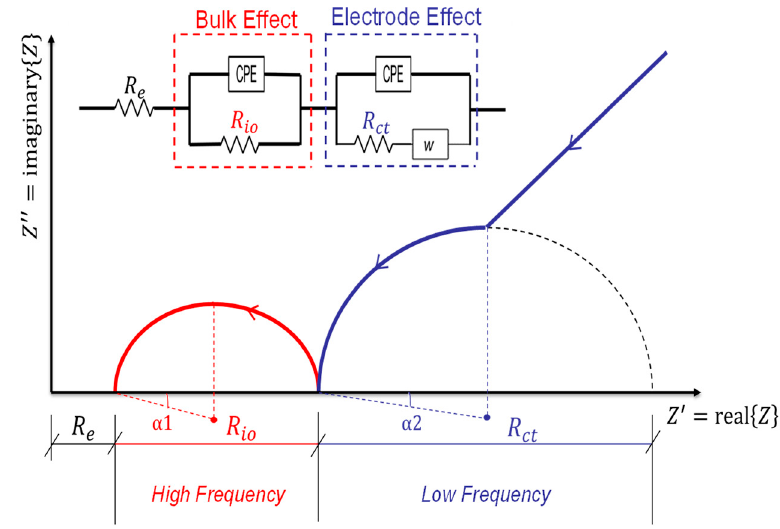
Figure 12. The equivalent circuit model of McCarter [150] and its representation on the complex plane.